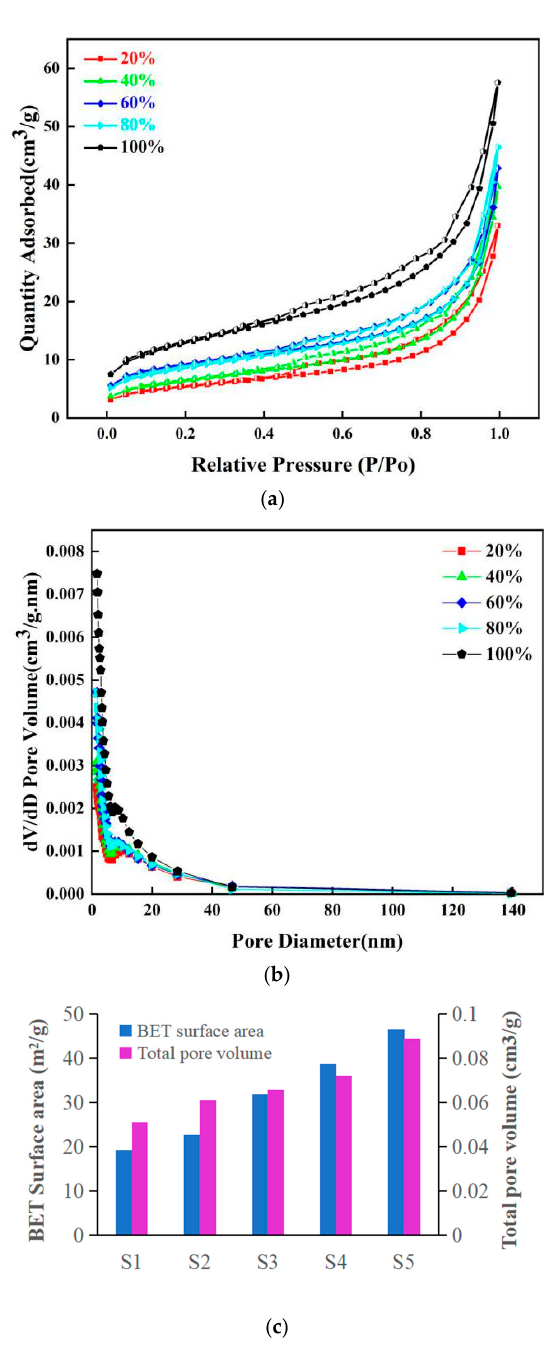
Figure 7. Adsorbed quality and pore volume for simulated AMD titrated slags, ( a ) surface area; ( b ) pore volume, ( c ) BET surface area and total pore volume. Table 4. Compositions of real AMD.